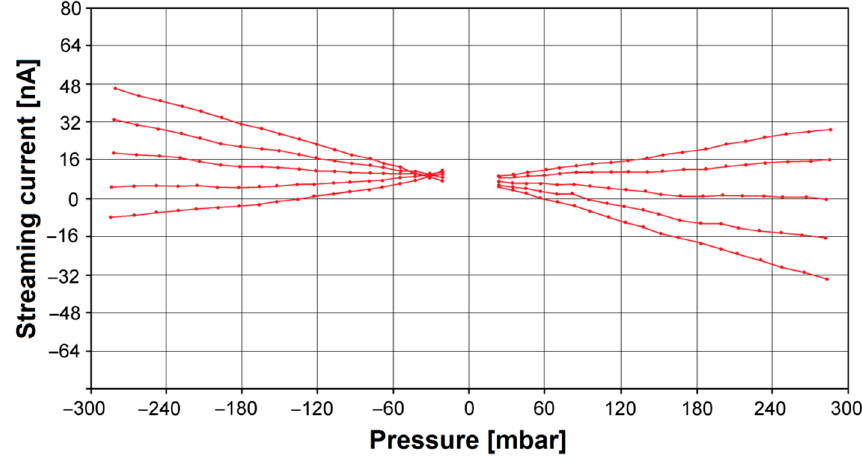
Figure 6. Streaming current vs. differential pressure for the Ti–13Zr–13Nb alloy after anodizing at various pH of the electrolyte.